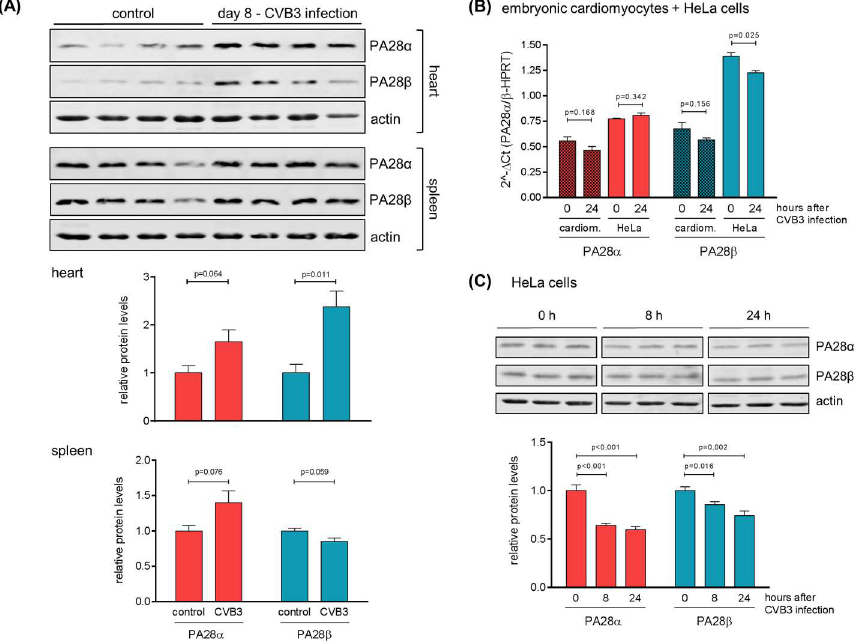
Fig 1. Regulation of PA28 αβ during CVB3 infection. (A) 6–8 weeks old, male C57BL/6mice (n = 4) were infected with CVB3 and sacrificedat day 8 after infection. Age- and gender-matched naive mice (n = 4) served as a control. Tissue homogenates of heart and spleen were analyzedby Western blotting to determine PA28 α and PA28 β protein levels. Actin served as a loadingcontrol. Densitometric analysiswas performed and PA28 α /PA28 β levels are shown as relativeintensitieswith a normalization basedon the respectivelevels of actin (means + SEM, n = 4). (B) Primary embryonic cardiomyocytes (eCMs) obtainedfrom wild-typemice and HeLa cells were infected with CVB3 at MOI 0.1 for 0 or 24 h. PA28 α /PA28 β mRNA levels were determinedby real-time qPCR (means + SEM, n = 3). (C) HeLa cells were infected with CVB3 at MOI 0.1 for indicated lengthsof time. PA28 α and PA28 β protein levels in total protein extracts were determined by Western blotting. The densitometric analysisof PA28 α /PA28 β protein levels is depictedas relativeintensities(means + SEM, n =